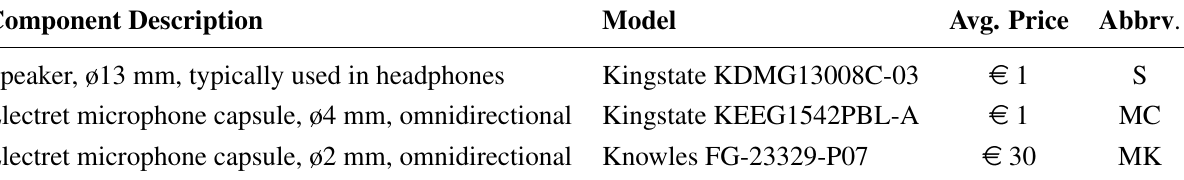
Table 1. The components listed here were used to assemble the self-testing noise sensors